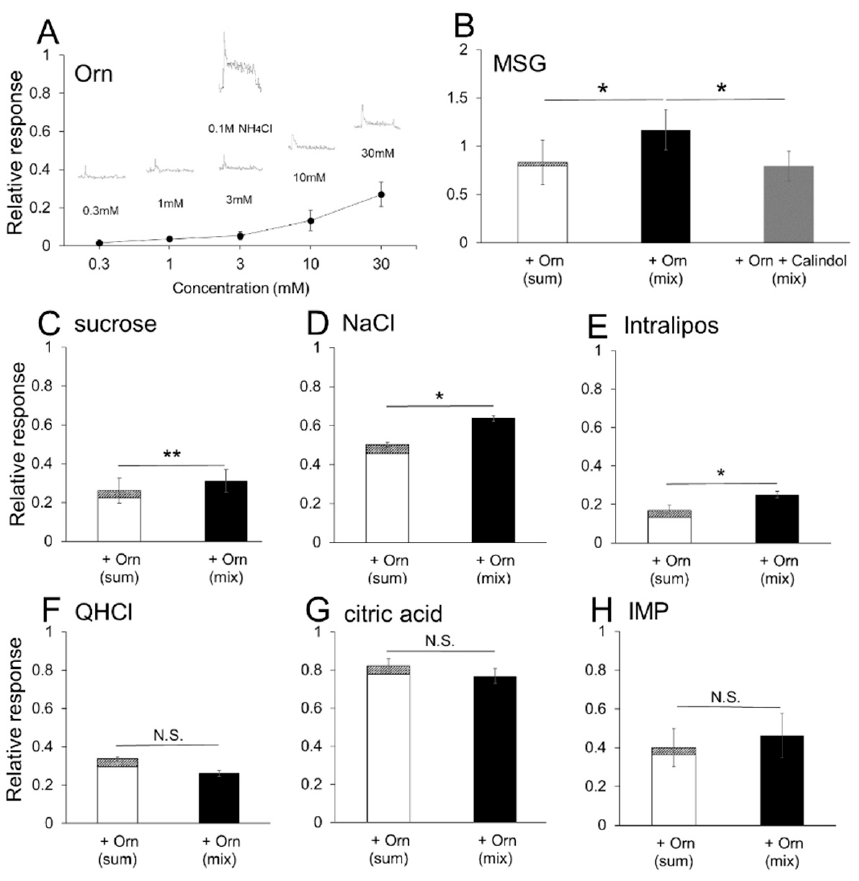
Figure 8. Quantitative representation of the magnitude of chorda tympani responses. ( A ) A concentration-response curve of the effects of aqueous L-ornithine (Orn) solutions on nerve responses. ( B ) The sum of the individual responses to 0.05 M MSG and 1 mM Orn, the response to a binary mixture of 0.05 M MSG and 1 mM Orn, and a mixture of MSG, Orn and 0.6 mM calindol. ( C ) The sum and mixture of 0.05 M sucrose and Orn. ( D ) The sum and mixture of 0.05M NaCl and Orn. ( E ) The sum and mixture of 10% Intralipos and Orn. ( F ) The sum and mixture of 0.02 M QHCl and Orn. ( G ) The sum and mixture of 0.02 M citric acid and Orn. ( H ) The sum and mixture of 0.01 M IMP and Orn. Each value is mean ± SE; n = 5. * p < 0.017 (after Bonferroni correction) for ( B ), * p < 0.05, ** p < 0.01 (paired t -test, two-tailed) for ( C – E ). N.S., not